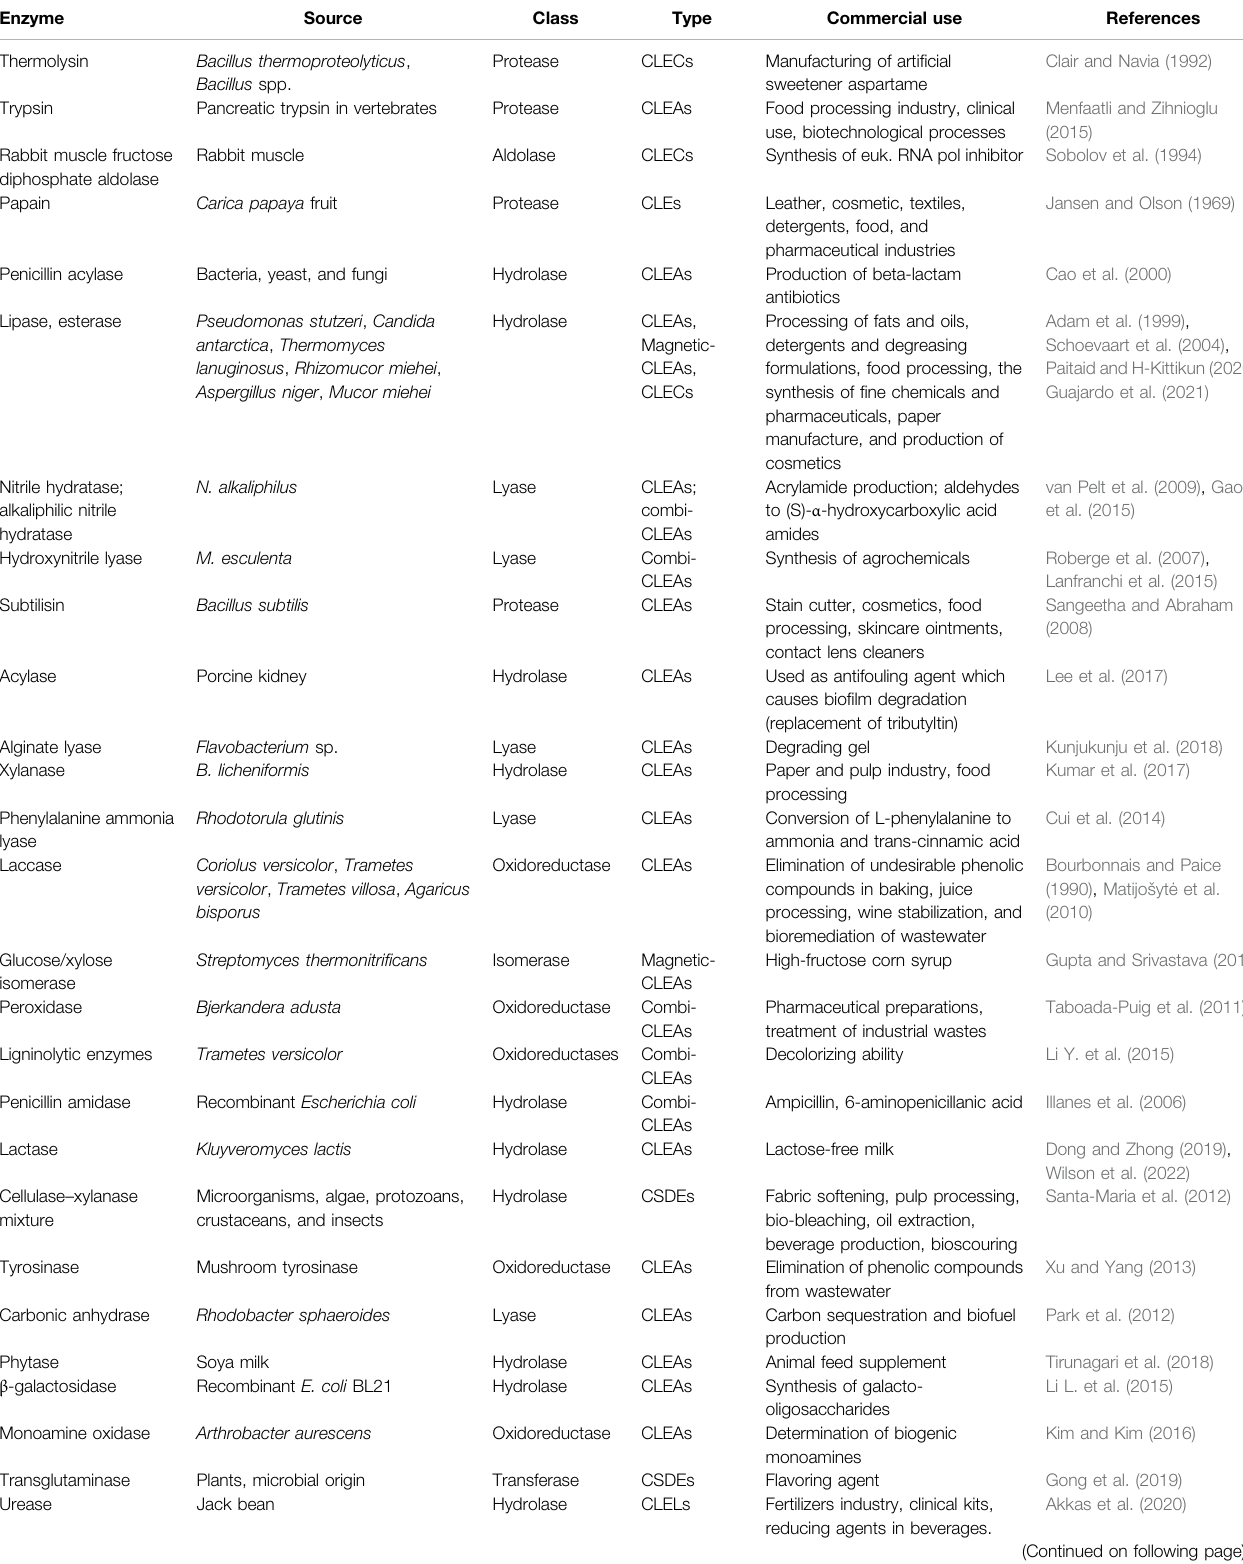
TABLE 3 | Commercial uses of carrier free